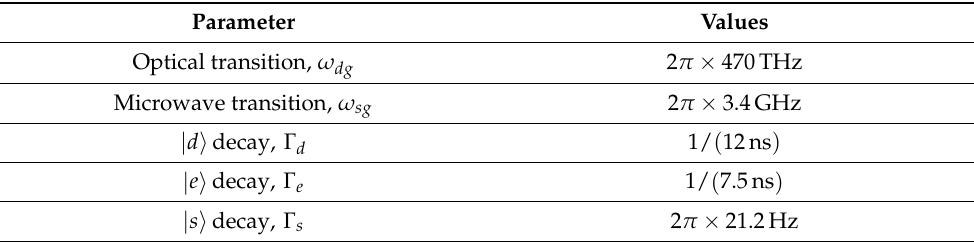
Table 2. NV center parameters as used in our simulations.